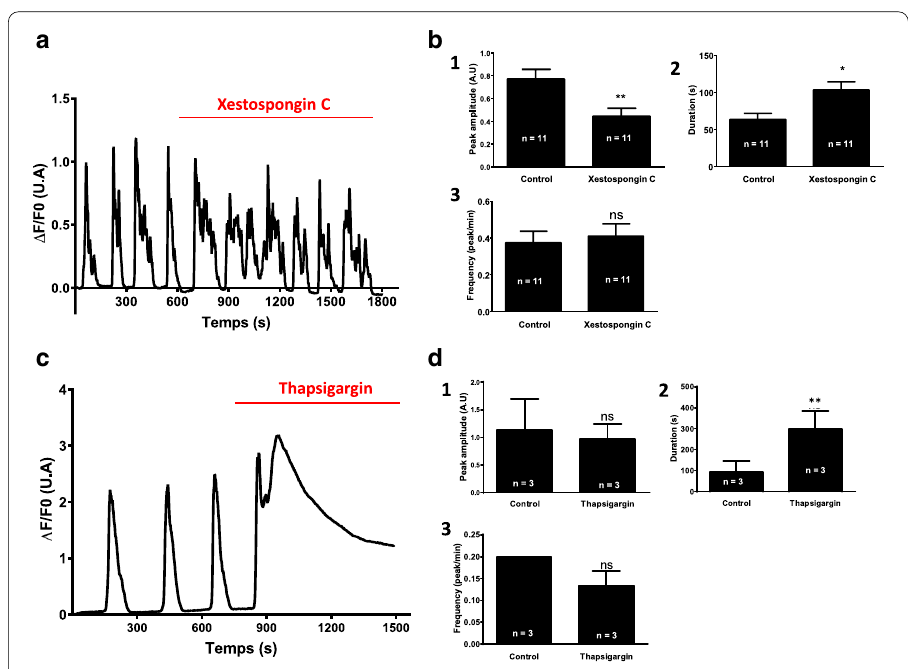
Fig. 5 Role of SERCA and IP3 receptors on spontaneous calcium activity recorded in W8B2 + CSCs after 28 days of in vitro differentiation. a Effect of 5 µM xestospongin C (IP3 receptor inhibitor) and c 1 µM thapsigargin (SERCA inhibitor) on spontaneous calcium activity recorded in differentiated CSCs. Graphs illustrate variations in [Ca 2 + ] i represented by changes in the ΔF/F0 ratio. ΔF F F0 (F: fluorescence emitted = − by GCaMP at a given time; F0: basal fluorescence emitted by GCaMP). Bar graphs (1), (2), (3) represent the evolution of the peak amplitude, the duration and the frequency of calcium oscillations, respectively, recorded from differentiated W8B2 + CSCs after treatment with xestospongin C (5 µM) ( b ) and thapsigargin (1 µM) ( d ). (N 3 patients, n: represents the number of events (oscillations) recorded, AU: arbitrary unit, ns: = not significant). *p < 0.05, **p < 0.01 vs. control; t‑test paired followed by Wilcoxon